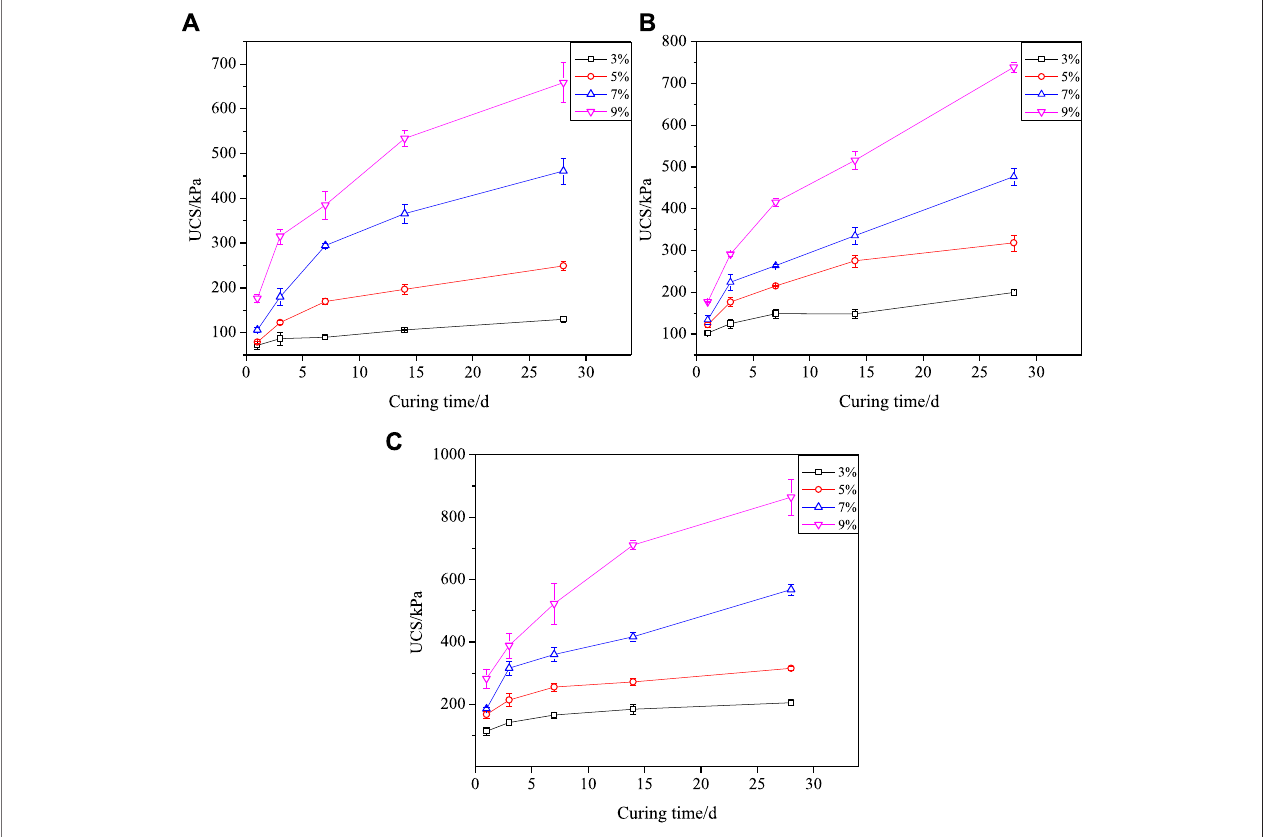
FIGURE 3 | The value of UCS corresponding to curing times under different solid content. (A) 68% solid content (B) 72% solid content (C) 76% solid content.